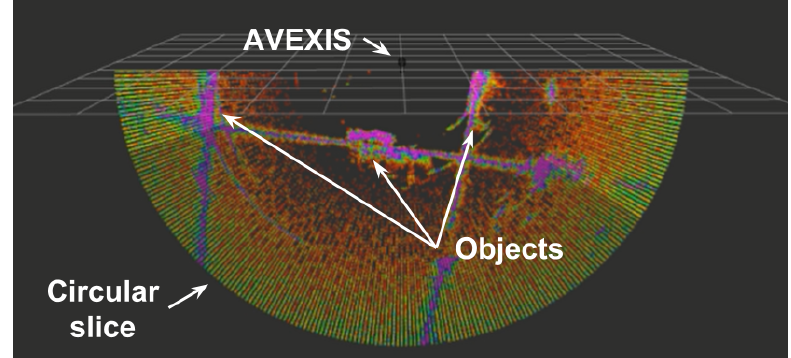
Figure 9. A 2D slice of the sonar during the technical demonstration at the Naraha Nuclear Test Facility.